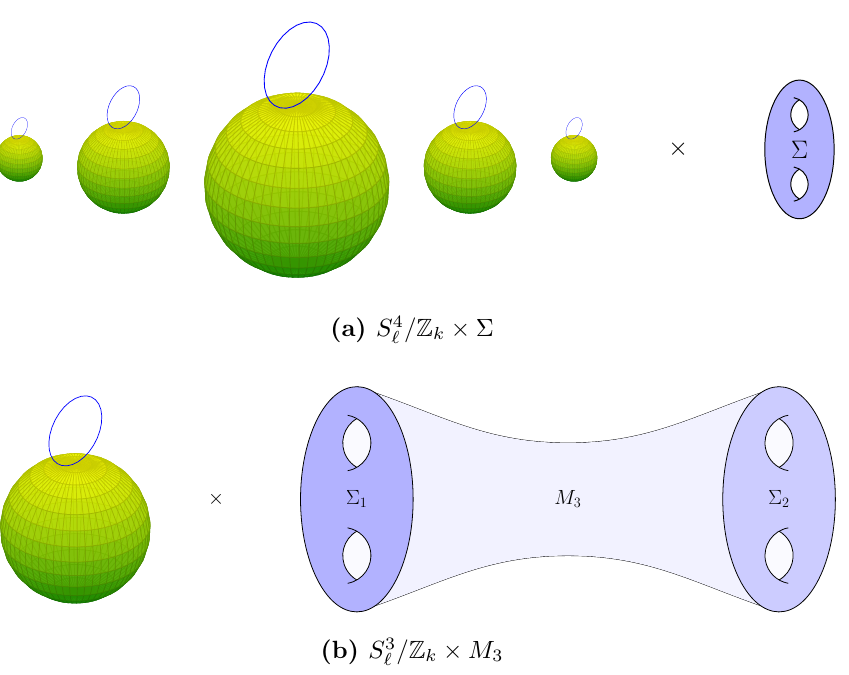
Figure 1. The geometries associated to (a) the 4d-2d frame and (b) the 3d-3d frame. The Hopf (cid:12)ber of the S 3 is indicated in